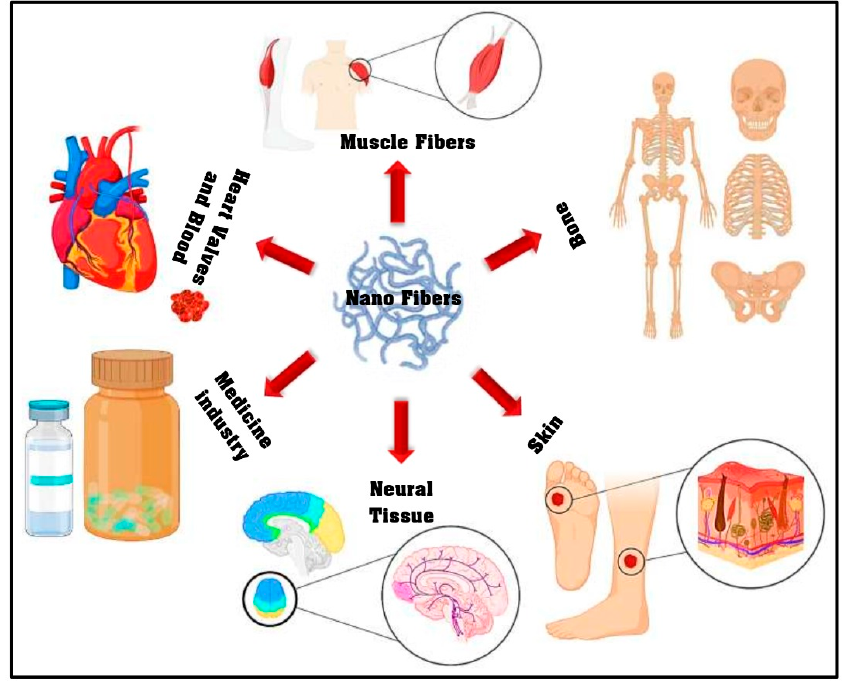
Figure 1. The electro-spun nano-fiber application in different biomedical fields (adapted from Miguel et al. [21]).